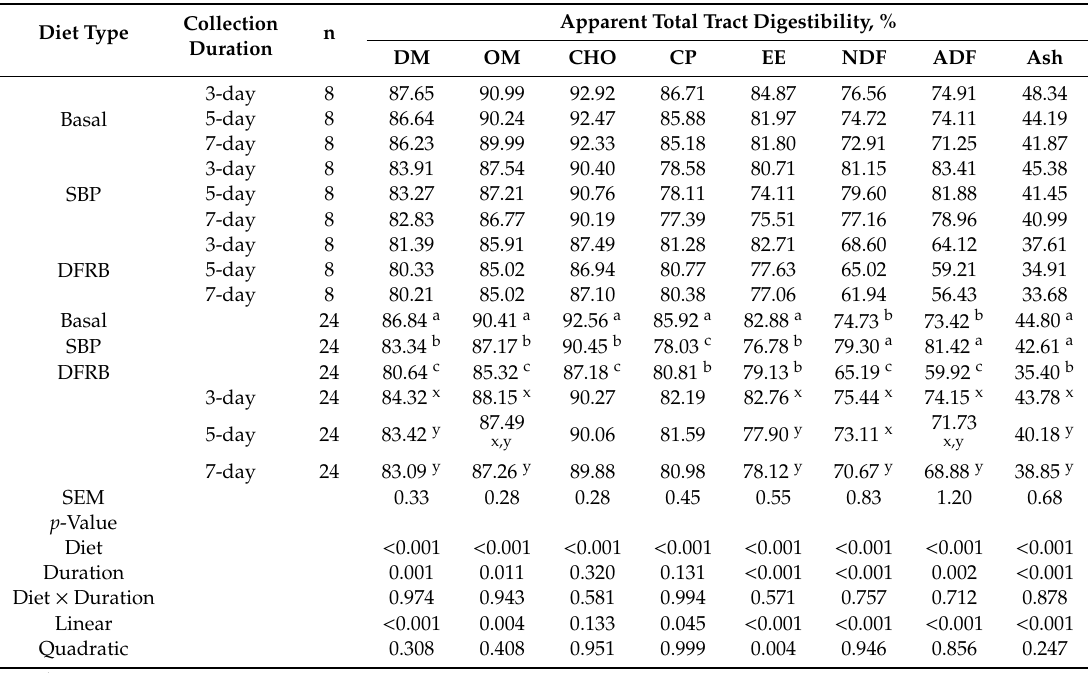
Table 4. E ff ect of collection duration on nutrient digestibility for experimental diets fed to growing pigs 1